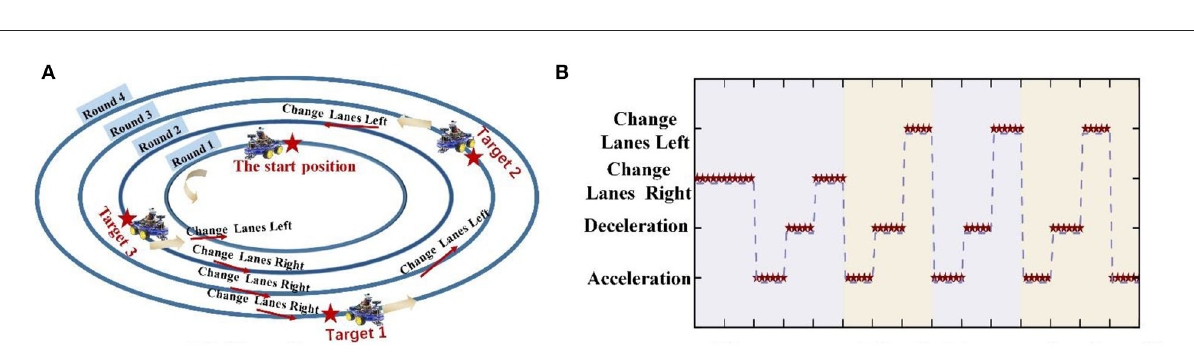
FIGURE9 Online scenario and optimal recognition performance within a single session for S2. (A) The online scene. (B) One representative decision procedure from